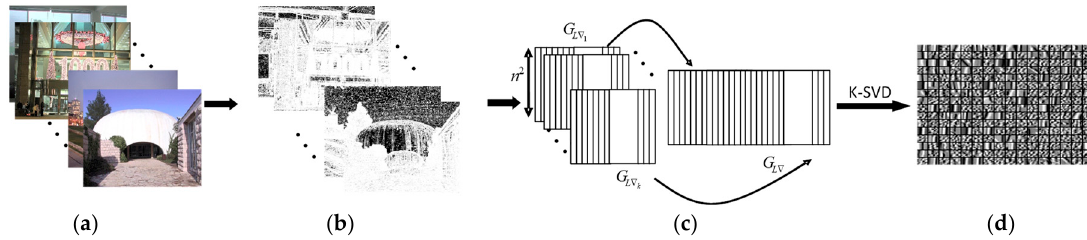
Figure 4. Dictionary learning in the gradient domain: ( a ) Clear images of indoors and outdoors; ( b ) Luminance gradient map; ( c ) Lexicographical vector; ( d ) Over-complete dictionary.